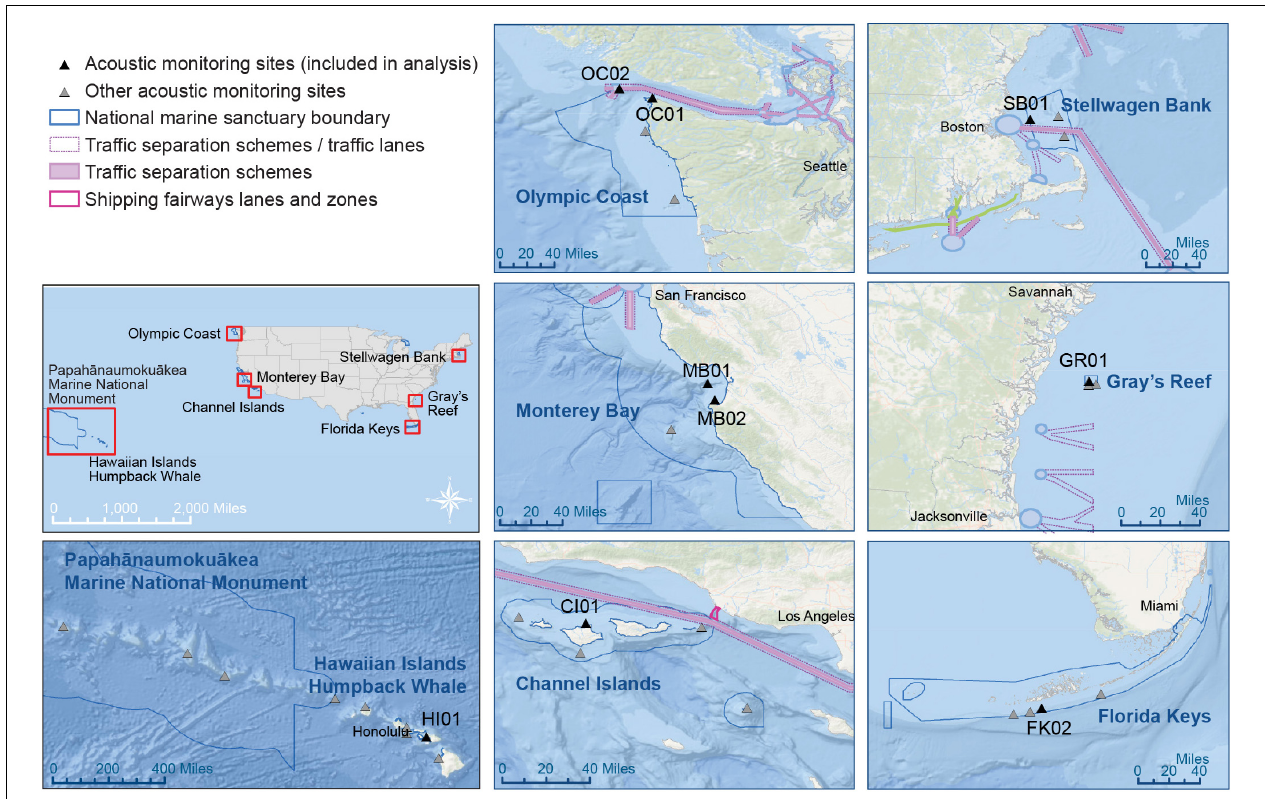
FIGURE 2 | Map of sites from the Sanctuary Soundscape Monitoring Project (SanctSound) used in this study. A variety of features are shown, including bathymetry, ports, designated shipping lanes, and